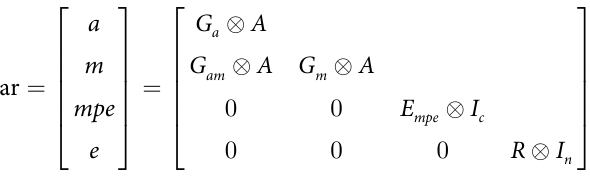
Uniform and Gaussian priors were assumed for fixed and random effects, respectively: